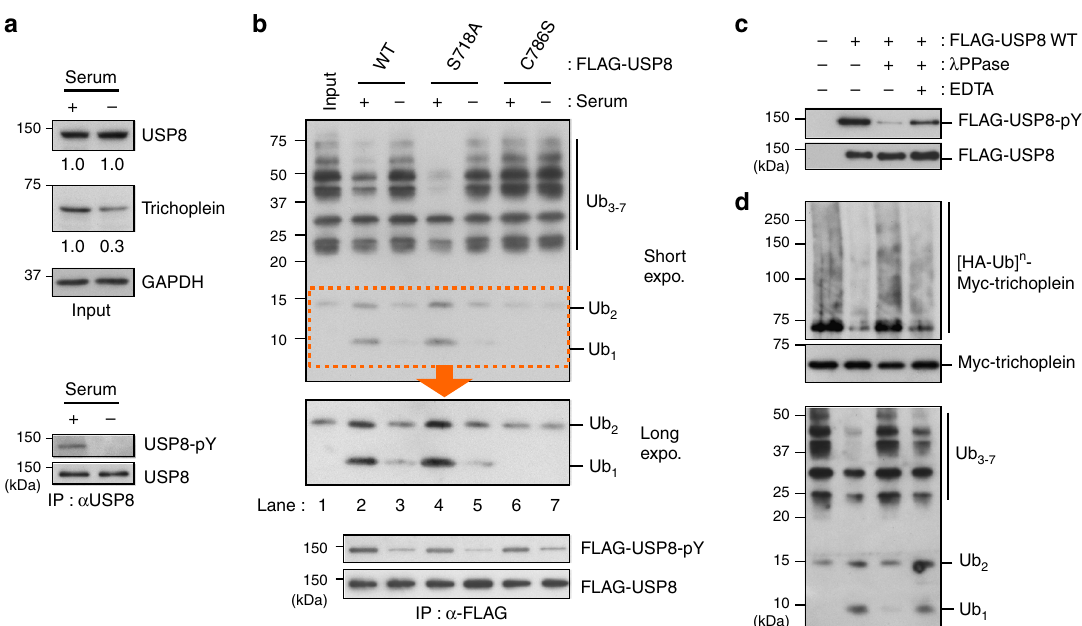
Fig. 6 Serum starvation induces dephosphorylation and inactivation of USP8. a USP8 was immunoprecipitated from PRE1 cells cultured in serum-fed medium (serum: + ) or subjected to 24 h serum starvation (serum: -), and the phospho-tyrosine (pY) levels of anti-USP8 immunoprecipitates were analyzed by immunoblotting. The levels of trichoplein, USP8, GAPDH in cell lysates (input) were also analyzed, and normalized intensities of trichoplein/ GAPDH and USP8/GAPDH are shown as mean from three independent biological replicates. b FLAG-USP8 variants (WT, S718A, and C786S) were immunopuri fi ed from serum-fed (+) or -starved (-) TetOn-RPE1 cells, and then incubated with ubiquitin oligomers (Ub 3 – 7 ) for 2 h at 37 °C. Anti-ubiquitin, anti-phospho-tyrosine (pY), and anti-FLAG immunoblotting are shown. c FLAG-USP8 WT immunopuri fi ed from serum-fed RPE1 cells (lane 2), were treated with λ PPase in the absence (lane 3) or presence (lane 4) of EDTA, and analyzed by anti-pY and anti-FLAG immunoblotting. d FLAG-USP8 WT proteins prepared in c were incubated with ubiquitin oligomers (Ub 3 – 7 ; top) or polyubiquitinated myc-trichoplein ([HA-Ub] n -myc-trichoplein; bottom) for 2 h at 37 ° C. Amounts of myc-trichoplein in the reactions are shown in a middle